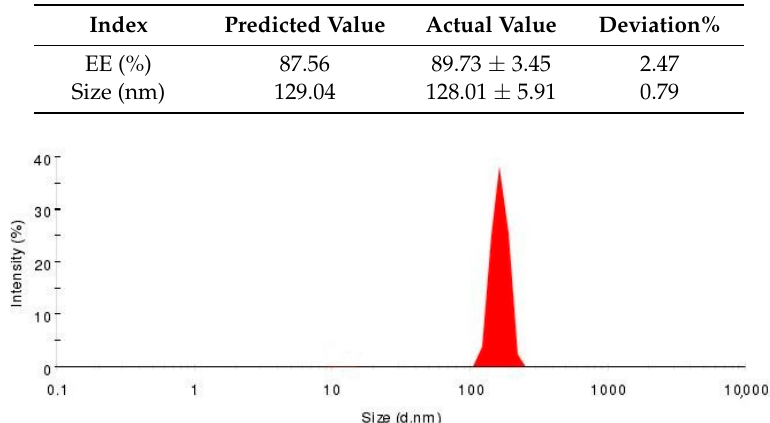
Table 4. Comparing the predicted values and actual values.